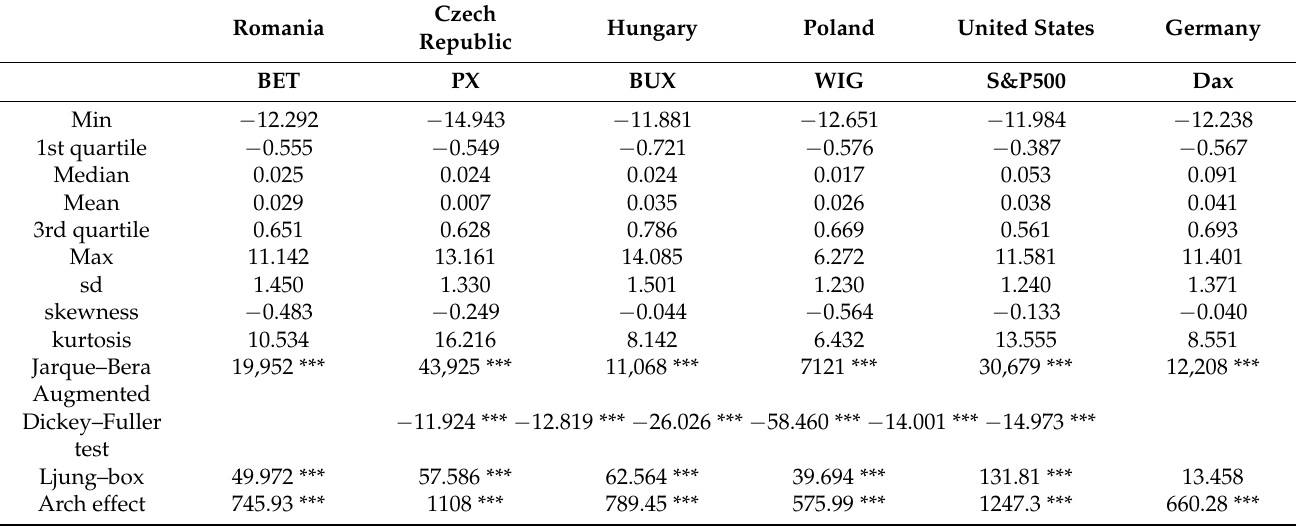
Table A1. Descriptive Statistics of Daily Stock